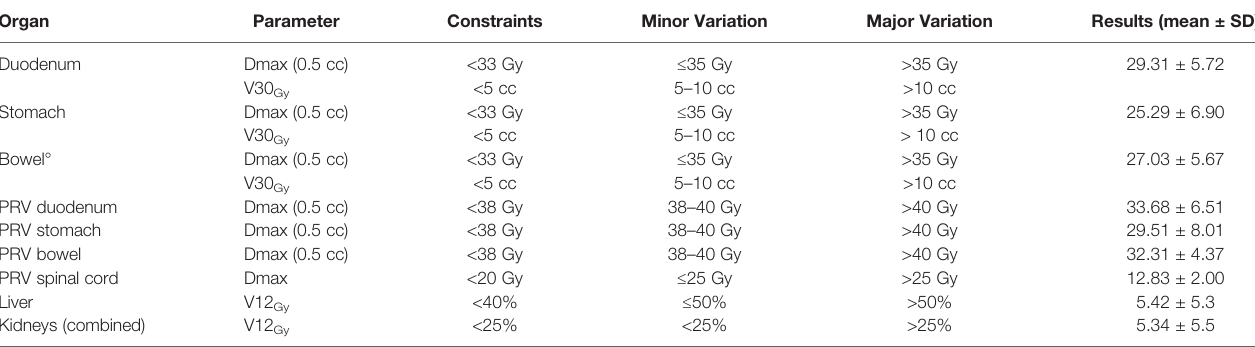
SD, standard deviation; cc, cube centimeter; Gy, gray; PRV, planning organ at risk volume. *60/40/33 Gy in 5 daily fractions to PTV sib /PTV t /PTV sip , respectively. °Small and large